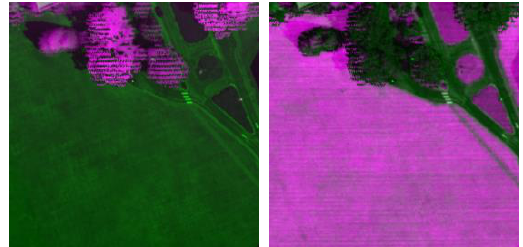
Figure 9. Registered aerial image (green) with LiDAR (magenta) DSM and intensity image (left and right).